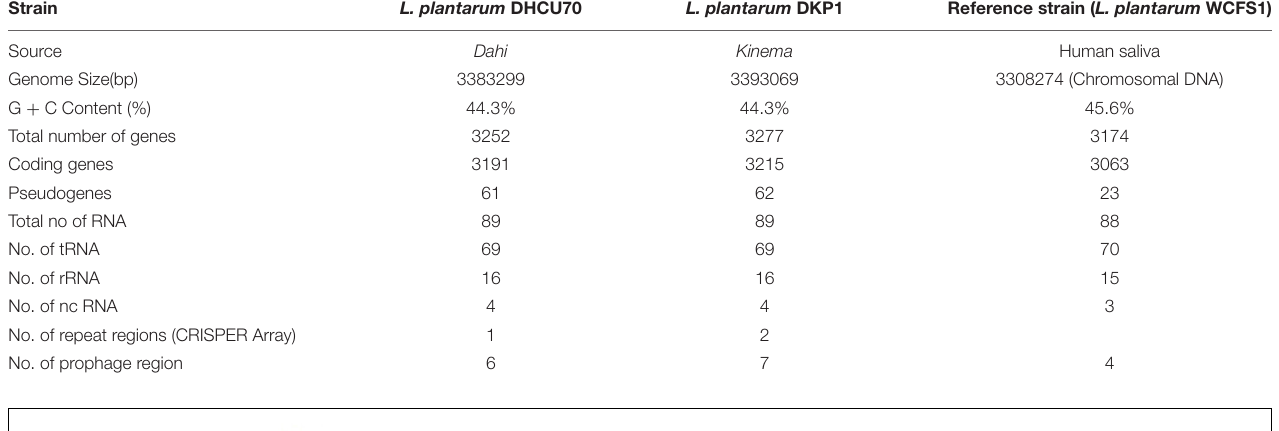
TABLE 1 | Comparison of the features of Lactobacillus plantarum genome with reference genome.